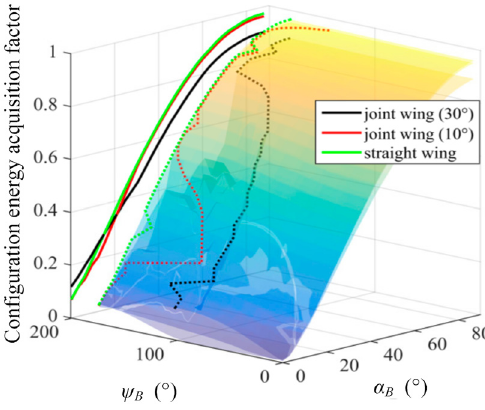
Figure 18. Optimal ψ B with the value of µ CEA .